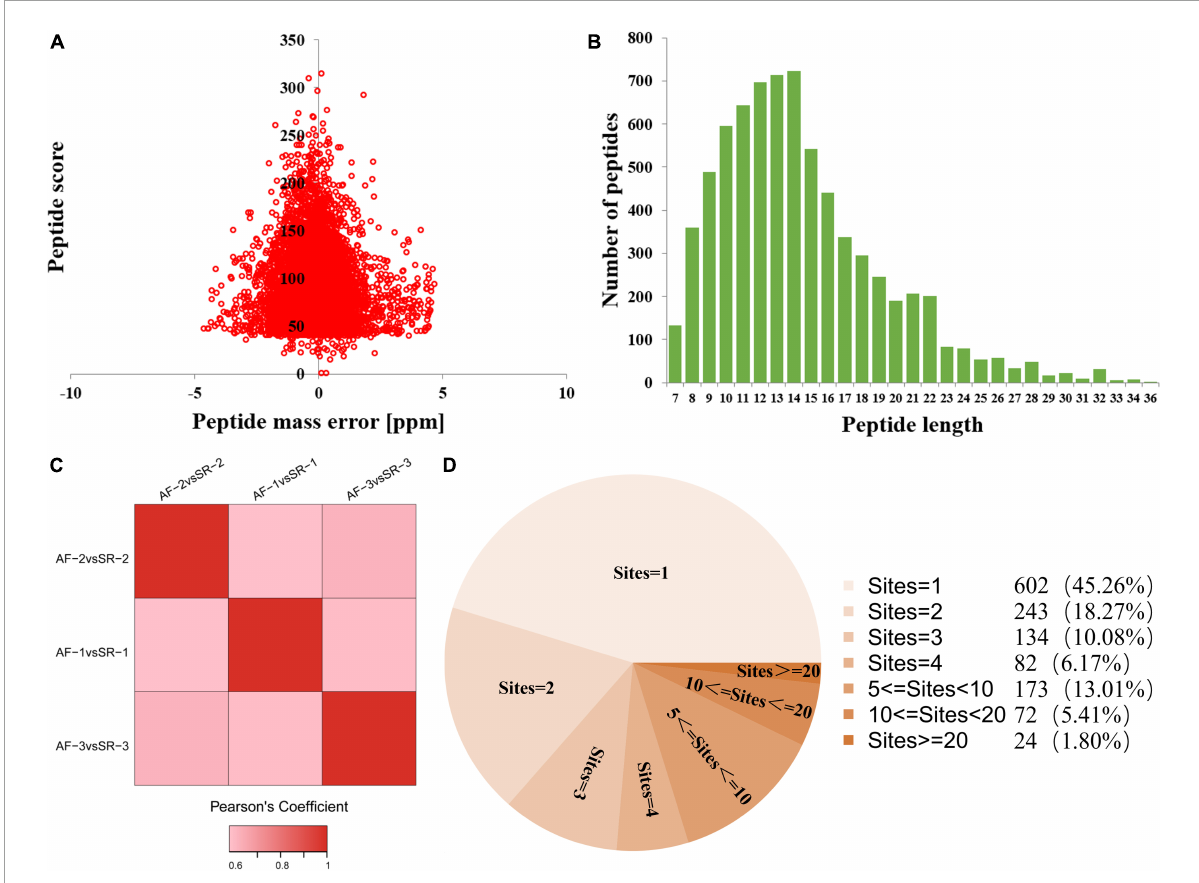
FIGURE1 Quality testing and identification of acetylated proteome in LAA tissues. (A) Mass error distribution of all identified peptides. (B) Peptide length distribution of all identified peptides. (C) Repeatability testing. (D) Pie chart showing the distribution of the number of Kac site identifications per Kac protein. AF, atrial fibrillation; SR, sinus rhythm; LAA, left atrial